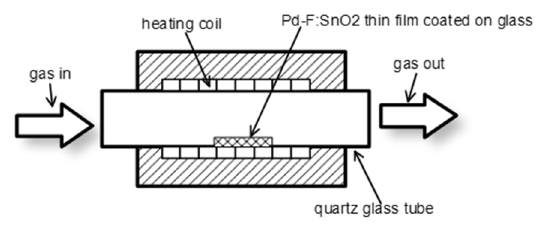
Figure 2. Tube furnace used in passivation of Pd-F:SnO 2 thin